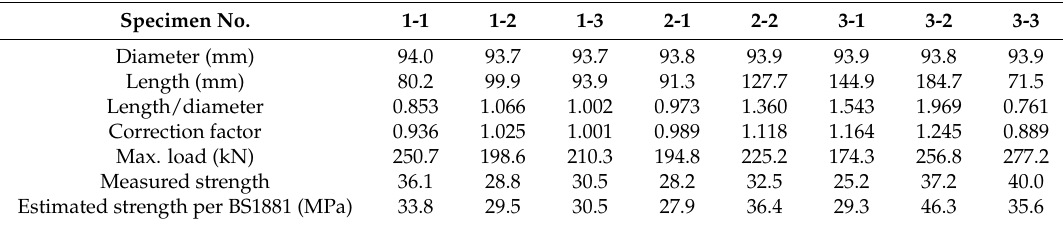
Table 1. Test results of sampled core cylinders.